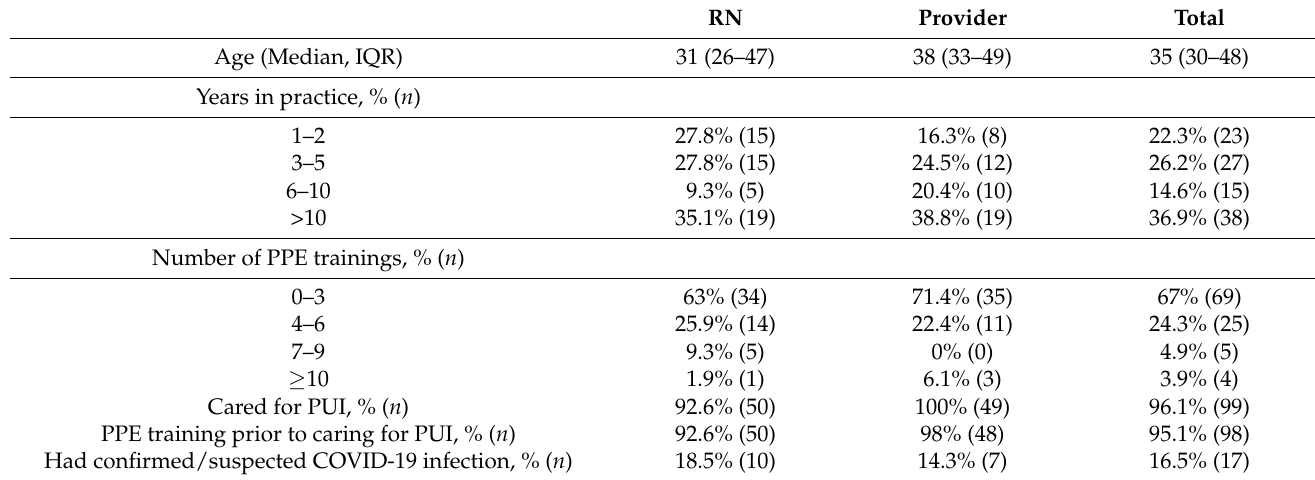
Table 1. Characteristics of respondents of personal protective equipment survey in two urban emergency departments during 2020 COVID-19 pandemic.